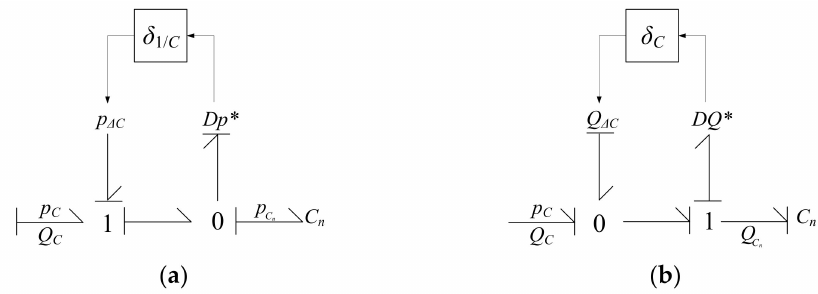
Figure 9. BG-LFT model of capacitive element: ( a ) integral type; ( b ) differential